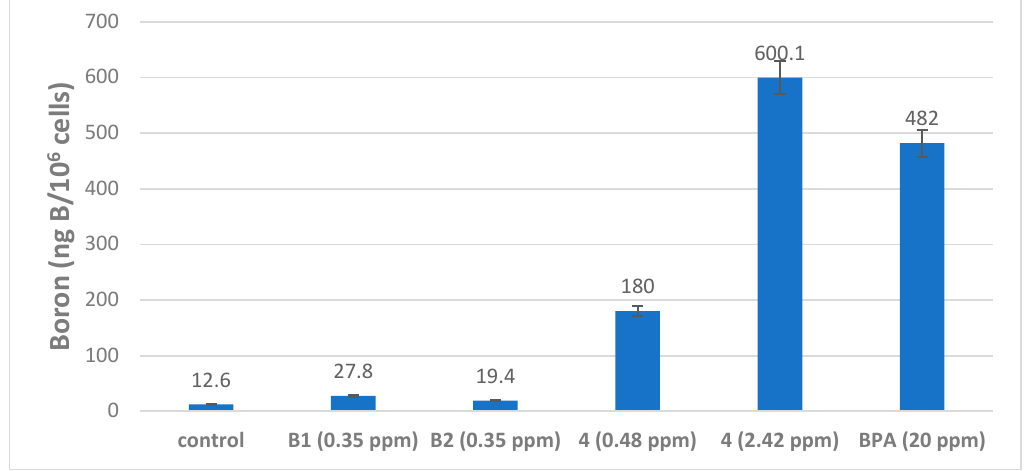
Figure 10. Boron concentrations in SCC VII cells.